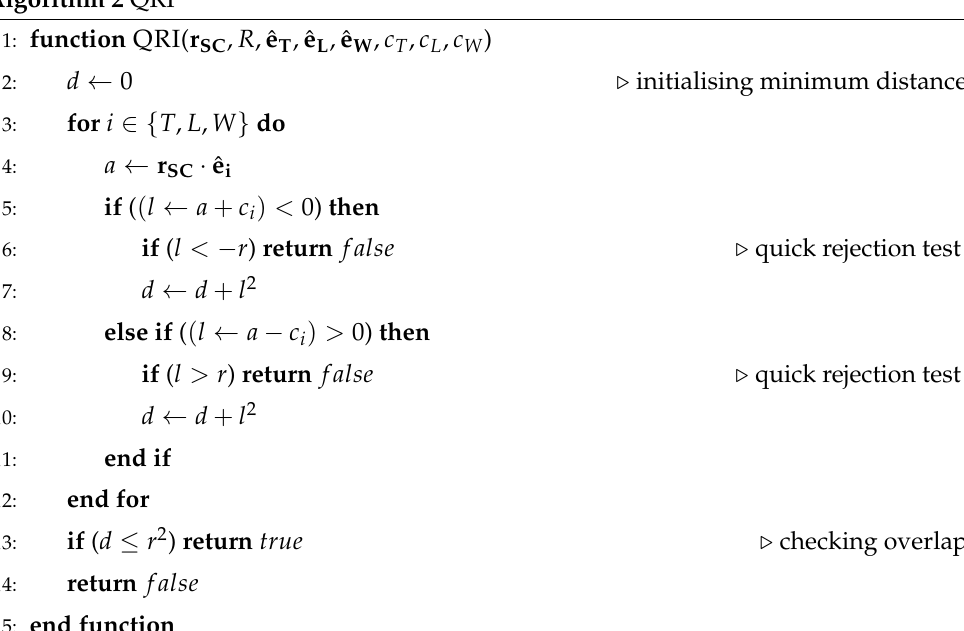
Figure 1. Schematic representation of a sphere and cuboid are centred, respectively, at r S and r C , and c L is half of the cuboid length. If r SC c L + R , then and do not S C